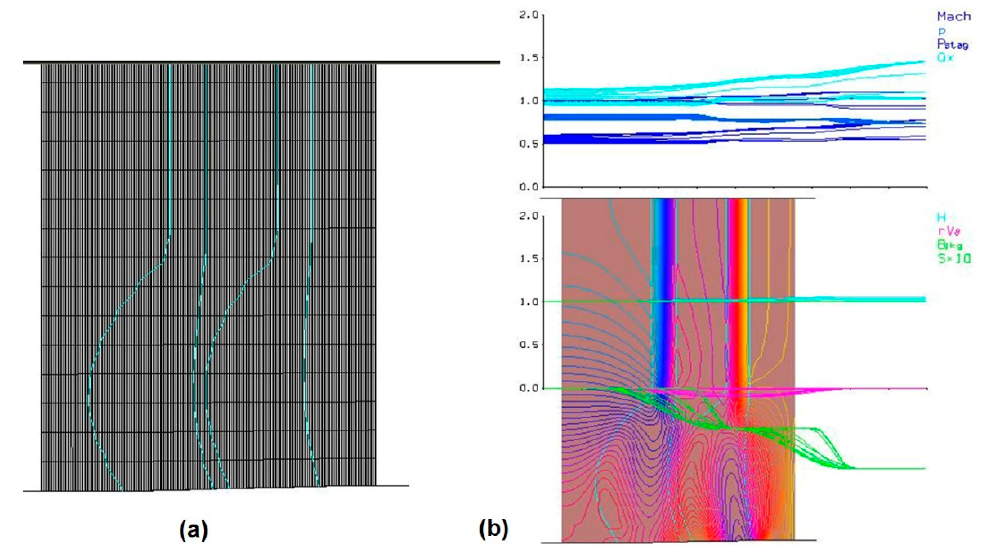
Figure 7. Unducted fan analyzed using T-Axi by extending the casing to simulate free-stream as shown in (a). Aerodynamic properties are plotted across the flowpath in (b).